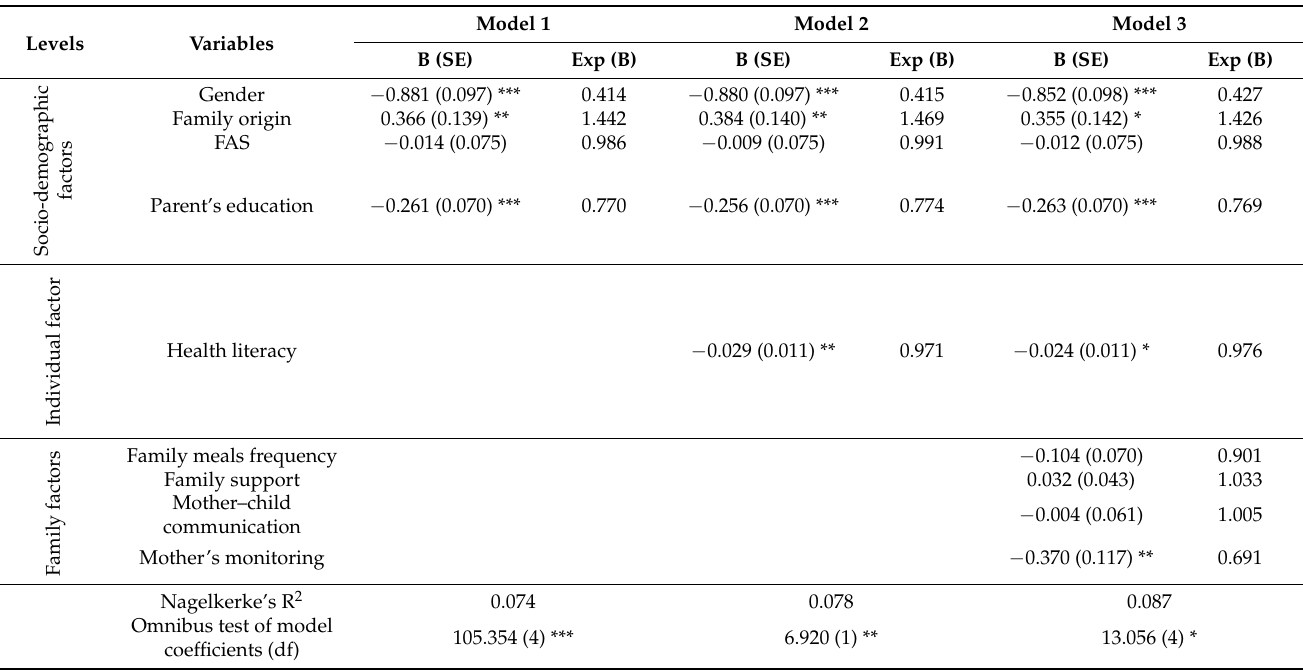
Table 6. Results of multiple binary logistic regression models predicting soft drinks